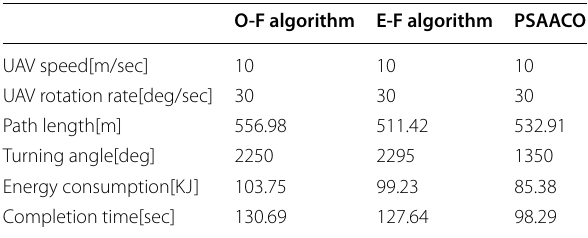
Table 14 Experiments on area 3 for performance comparison between PSAACO and algorithm in [39]